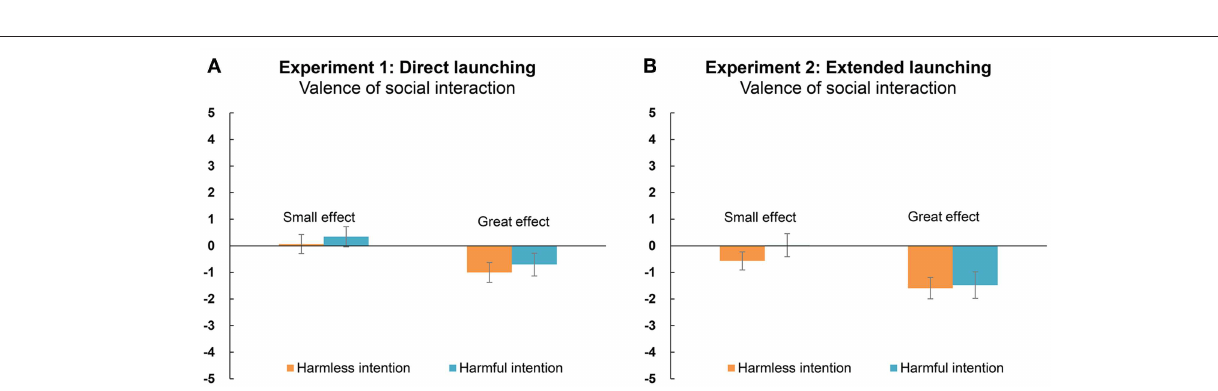
FIGURE 3 | Evaluations of the valence of a social interaction between the actor (i.e., purple hexagon) and the recipient (i.e., yellow square) under different acting conditions in Experiment 1 (A) and Experiment 2 (B) . A score of − 5 means a “strongly negative interaction,” 5 means “strongly positive interaction,” and 0 means “neural social interaction.” Error bars indicate the standard errors ( ±